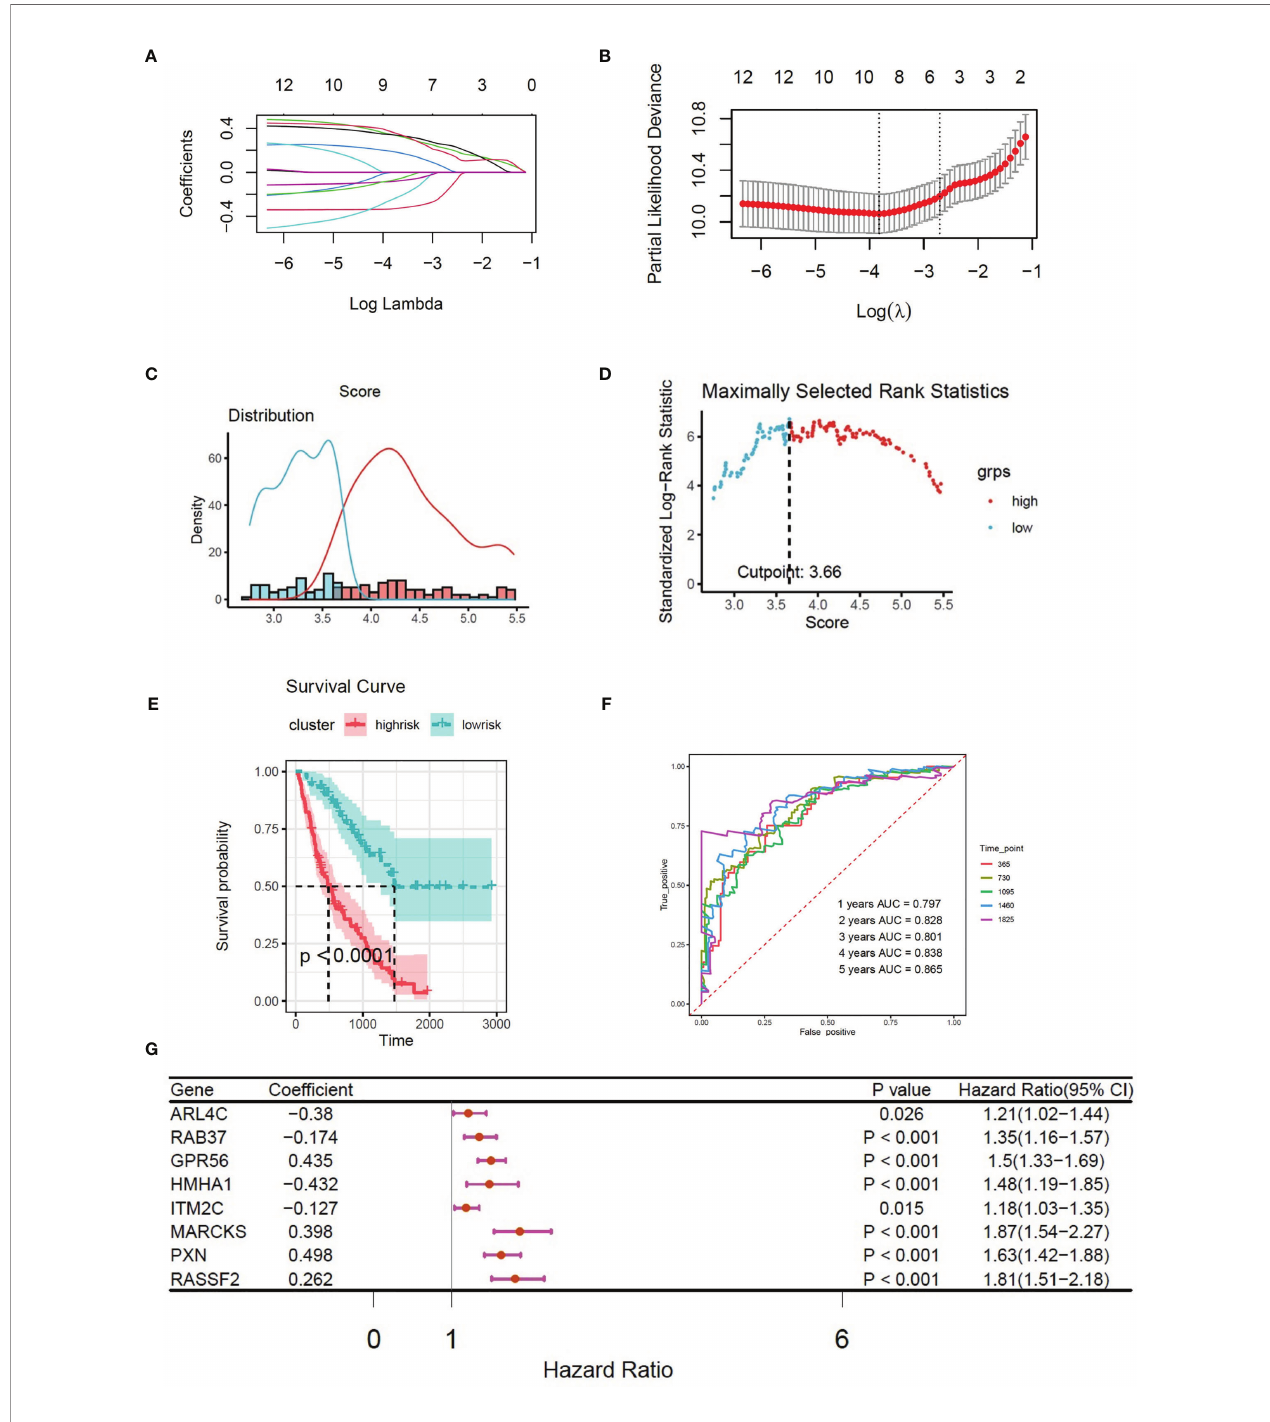
FIGURE 4 | (A) LASSO coef fi cient pro fi les of 8 CX3CR1-related immune in fi ltration genes. (B) Three-fold cross-validation of lasso analysis. Error bars represented the SE. The dotted vertical lines showed the optimal values. (C) Histogram based on maximally selected rank grouping. (D) The cut-off point with the maximum standard log-rank statistic was marked with a vertical dashed line. (E) Kaplan – Meier plot of overall survival in two clusters based on the risk models of CX3CR1- related immune in fi ltration genes (Risk score2). (F) The ROC curve in the risk models of CX3CR1-related immune in fi ltration genes (Risk score2). (G) Forest plot of 8 CX3CR1-related immune in fi ltration genes with P < 0.05 by univariate Cox